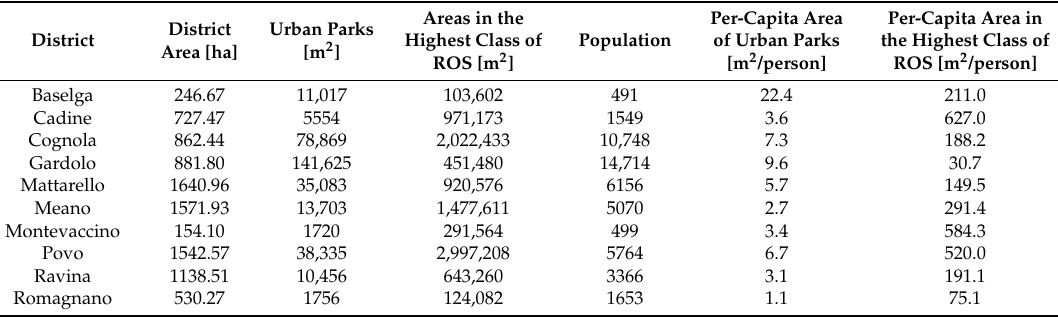
Table 1. District-level comparison among values of total and per-capita area of urban parks and total and per-capita area in the highest class of ROS.